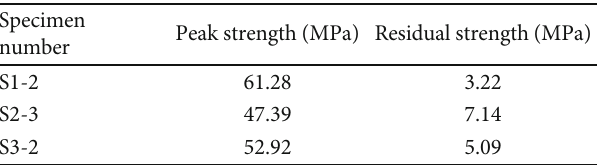
Figure 3: The stress and axial strain curves of the representative sandstone specimens. Table 2: The peak and residual strengths of the representative sandstone